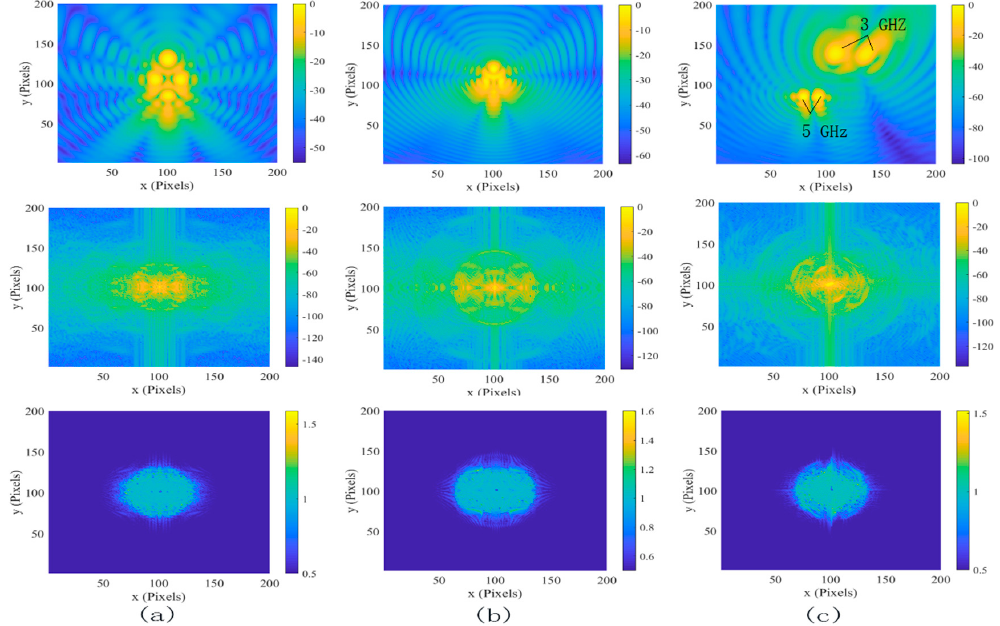
Figure 5. The original image of 4, 3, and 4 interference sources, and the logarithm spectral behavior of the coherent noise and Gaussian filter shape. ( a ) 2 GHz, ( b ) 4 GHz, and ( c ) 3 GHz and 5 GHz. Table 1. Maximum Sidelobe Level (MSL) and dynamic range (DR) results for electromagnetic interference sources (EMIS) at 2 GHz, 4 GHz, and 6 GH z before and after denoising.